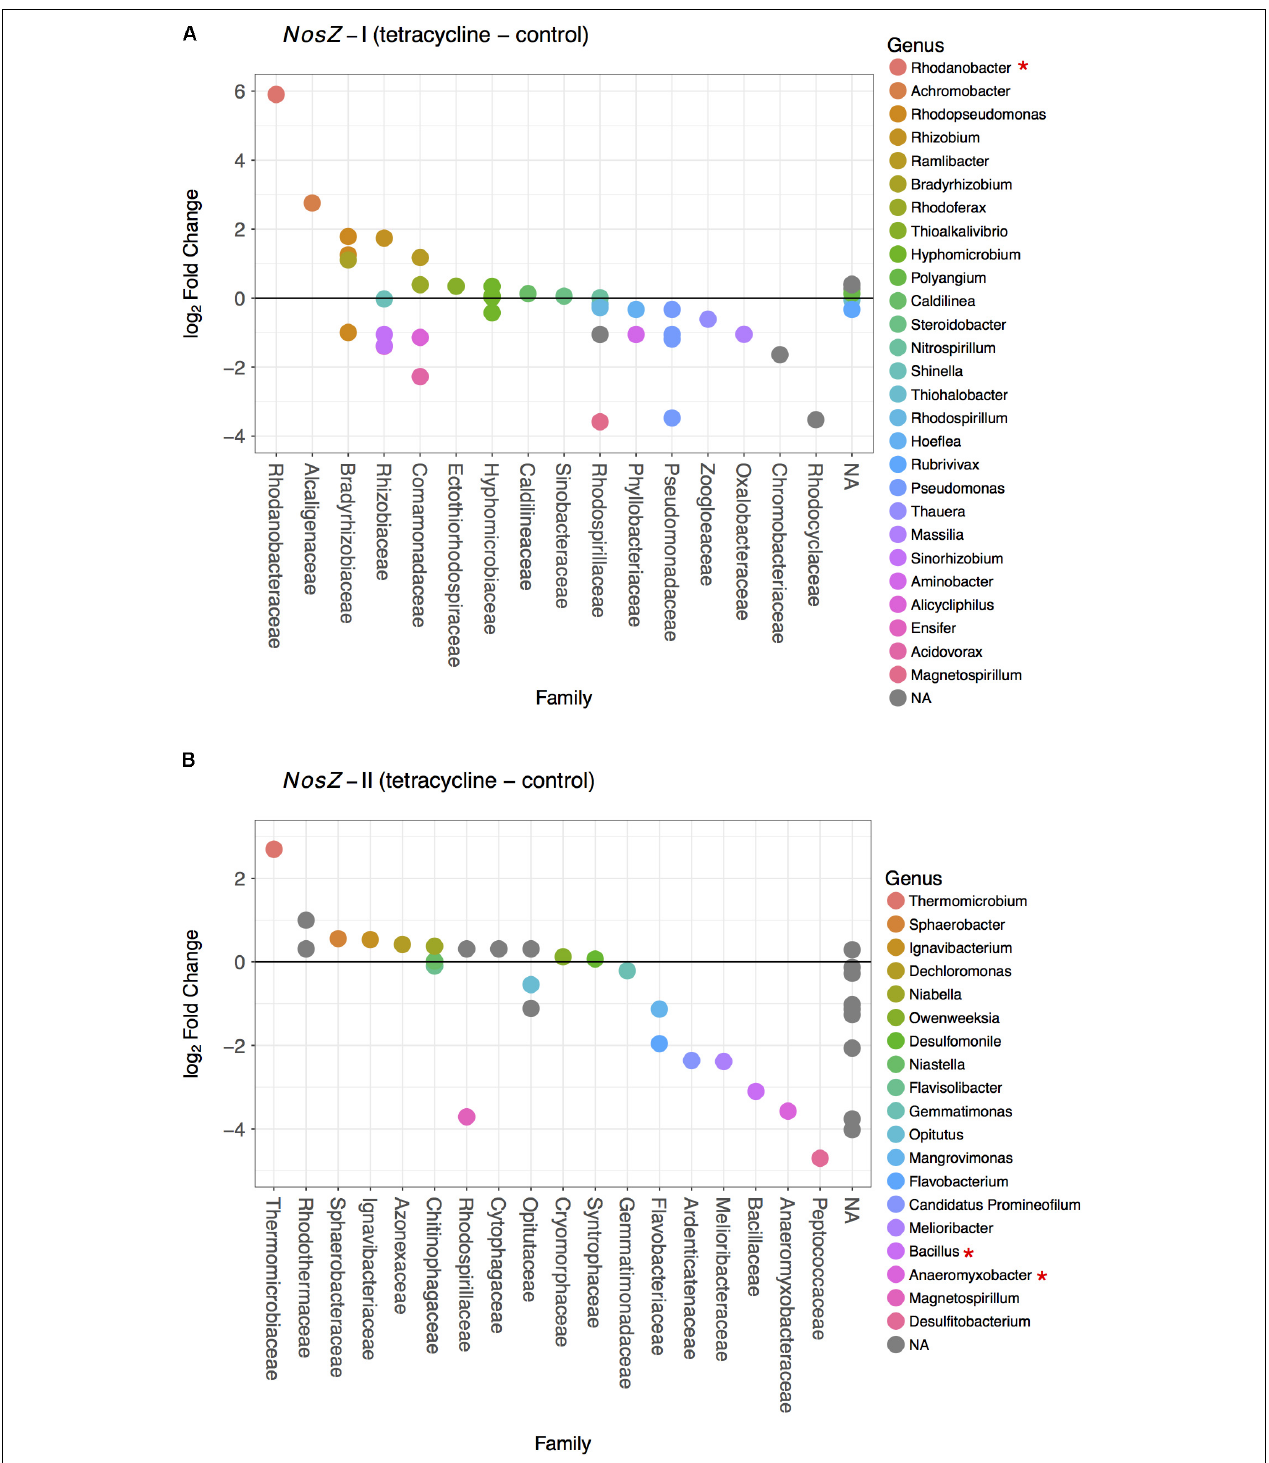
FIGURE 6 | Difference in the nosZ -carrying microbial community composition between tetracycline and control samples for nosZ -I (A) and nosZ -II (B) bacteria. Each dot denotes a taxon that is either higher (log 2 fold change > 0) or lower (log 2 fold change < 0) in the tetracycline treated samples when compared to the control samples. Taxa are organized by family in decreasing order and colored by genus. Normalized abundances were obtained by metabolic inference of 16S rRNA gene sequences using PAPRICA and tested for significant effects ( p < 0.05) of treatment by fitting the data into a generalized linear model (GLM) based on the negative binomial distribution. Taxa with significant difference between tetracycline and control samples are marked with ∗ in the legend.